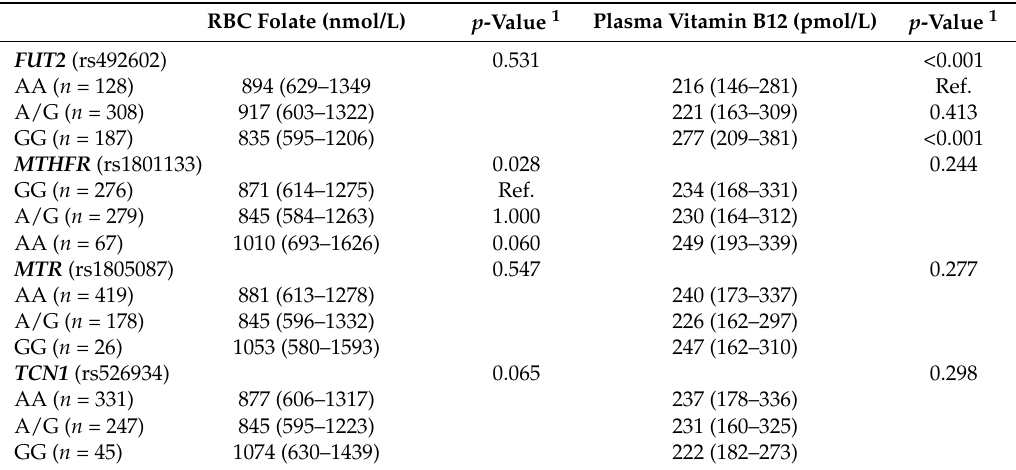
Table 2. Plasma vitamin B12 and RBC folate concentrations by FUT2, MTHFR , MTR , and TCN1 genotypes in the Newcastle 85+